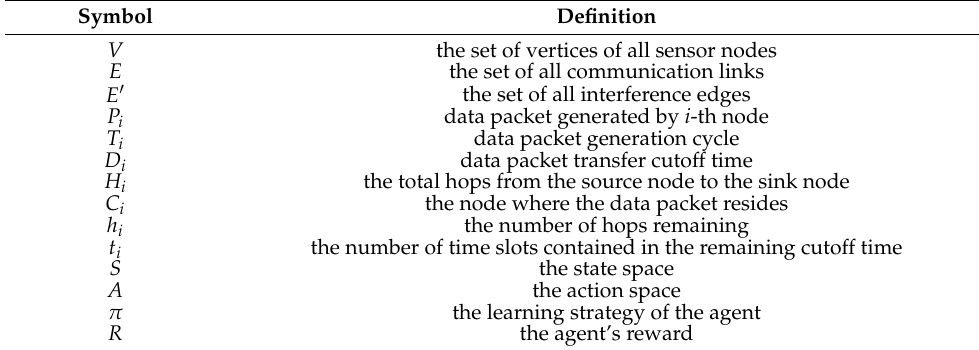
Table 1. Definition of the